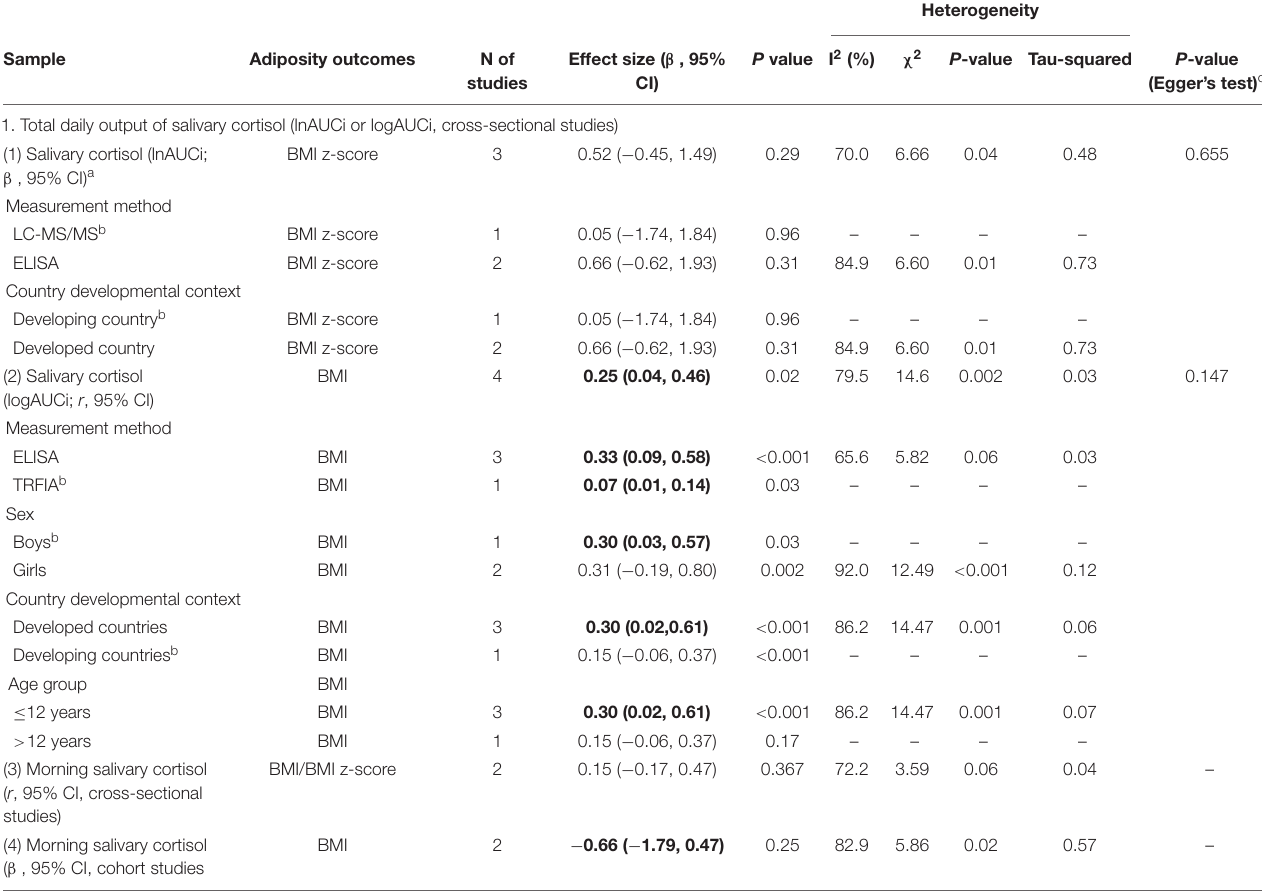
TABLE 3 | Overall and sub-group meta-analysis of the associations between salivary cortisol concentration and adiposity-related outcomes among children based on 11 included